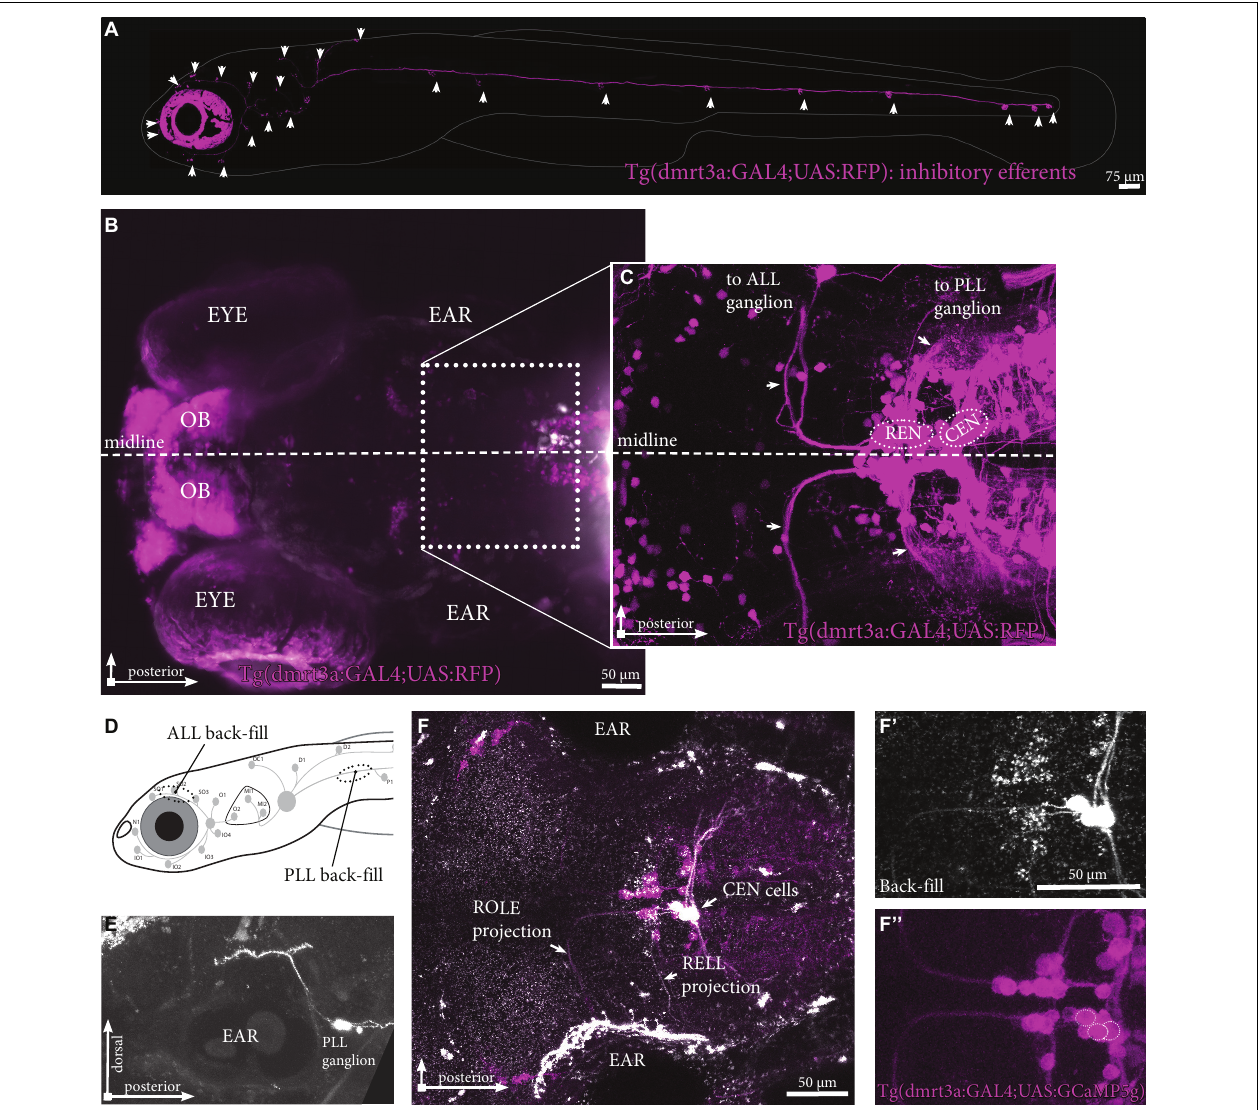
FIGURE 2 | Inhibitory efferent projections to the lateral line in zebrafish larvae. (A) Overview of the inhibitory efferent projections in a Tg( dmrt3a :GAL4;UAS:RFP) 5 dpf larvae. Arrowheads indicate sites of neuromast innervation. Note that this is not the original confocal image, but a modified version to show the inhibitory efferent projections only; for the original image, please see Supplementary Figure 1 . (B) Top view showing the head of the same larvae. Features marked are the eye, the ear and the olfactory bulb (OB; RFP-positive). Boxed area is shown in (C) . (C) Confocal image showing the REN and CEN in the hindbrain. Arrows indicate projections to the ALL ganglion and the PLL ganglion. (D) Schematic overview to indicate sites of ALL (S01-SO3; above the eye) and PLL (P1, above the yolk) back-fills. (E) Side view of a PLL back-fill. Back-fills were performed posterior of the PLL ganglion. Note the dendritic process from the ganglion to the brain (above the ear). (F) Overlay of back-filled inhibitory efferent cells in the CEN with the cells labeled by Tg( dmrt3a :GAL4;UAS:GCaMP5g). (F’) Back-fill of ROLE and RELL cells located in the CEN. (F”) Location of overlap by back-filled cells are indicated by white dotted circles in a Nacre Tg( dmrt3a :GAL4;UAS:GCaMP5g) larva. OB, olfactory bulb; ALL, anterior lateral line; PLL, posterior lateral line; REN, the rostral efferent nucleus; CEN, the caudal efferent nucleus nucleus; ROLE, the rhombencephalic octavolateral efferent neuron; RELL, the rhombencephalic efferent neuron to the lateral